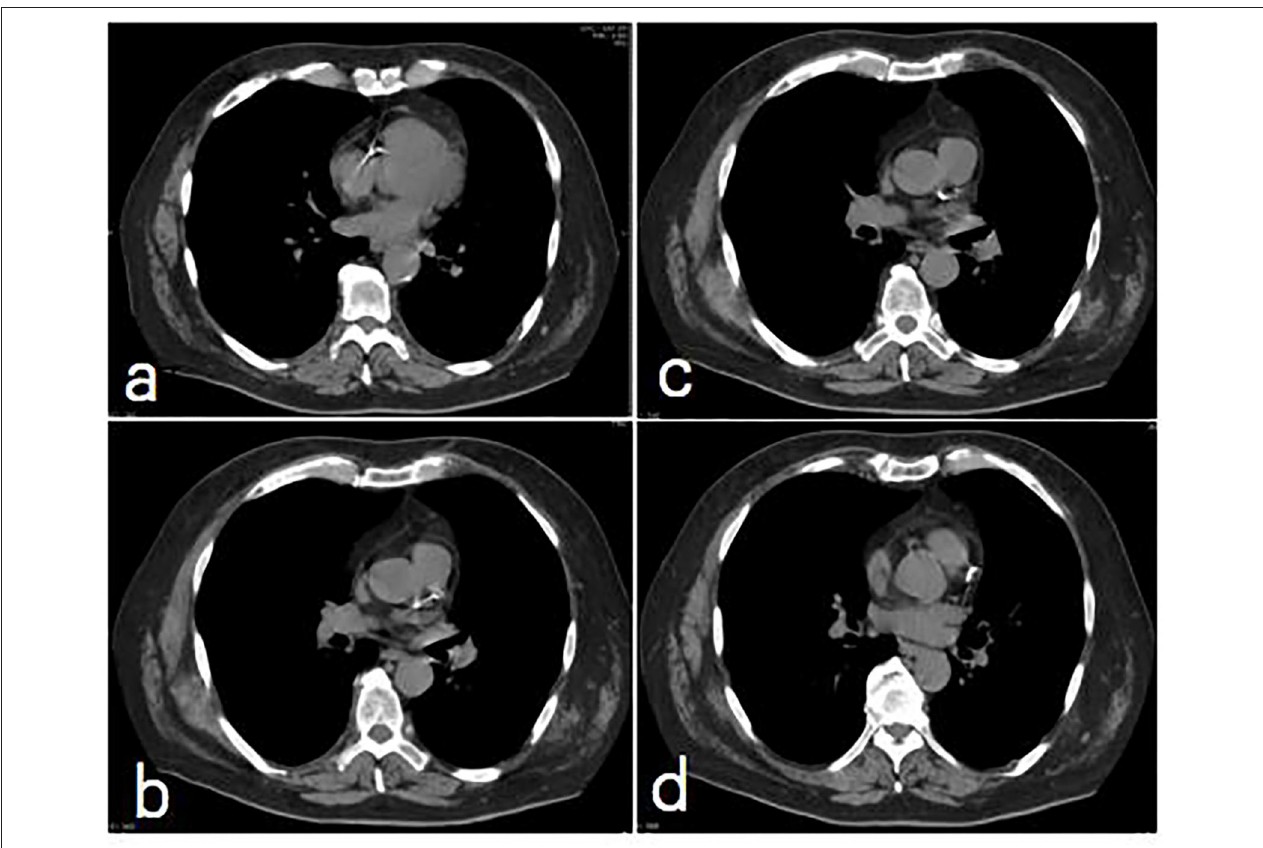
FIGURE 1 | A non contrast, non-gated Chest CT image series for CAC (a) RCA calcification score = 3; (b) LM calcification score = 3; (c) mid-LAD score = 3; (d) proximal LAD calcification score = 3. The total CAC score =